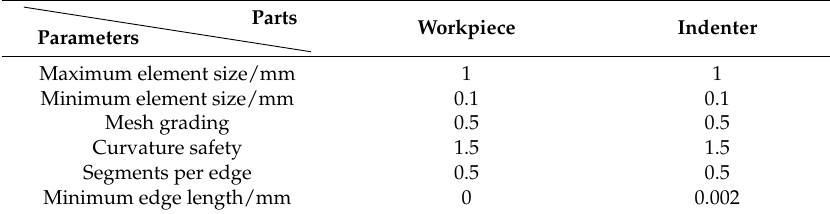
Table 4. Parameters related to the mesh process.